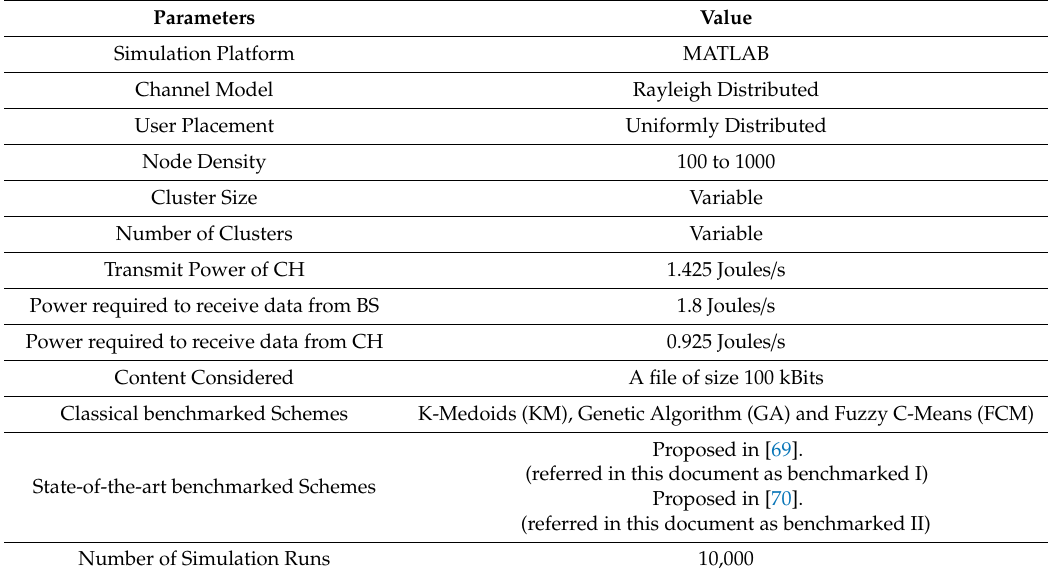
Table 3. Simulation